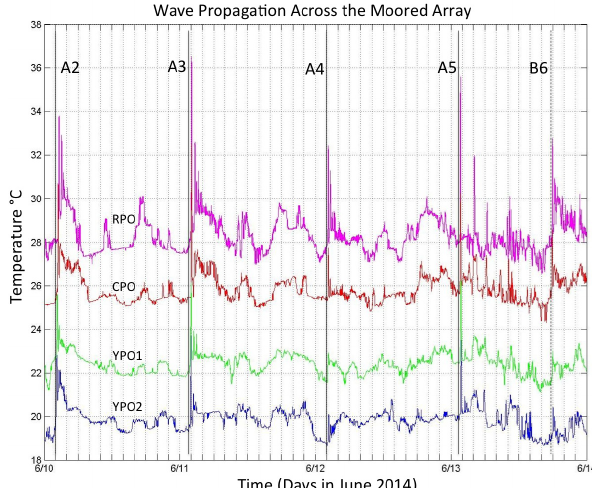
Figure 6. As in Fig. 5, except during 10–14 June 2014. In this plot, the time series have additionally been shifted relative to YPO2 by the propagation time between moorings so that individual waves line up. The lag times used are 36.5min for YPO1, 66.8min for CPO, and 122.8min for RPO.